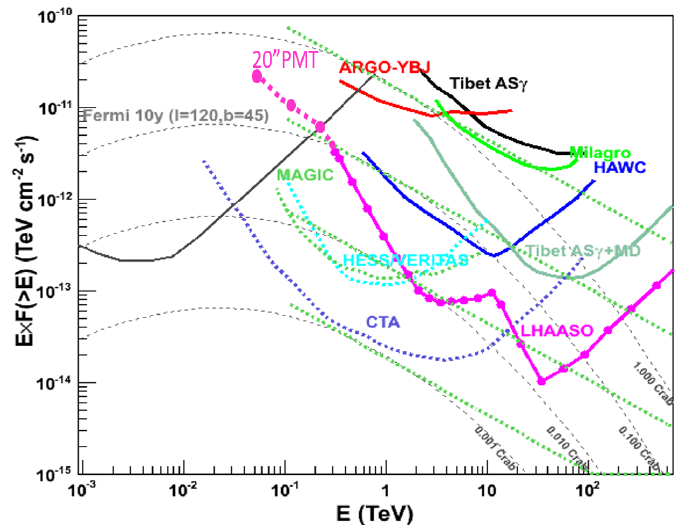
Figure 4. Sensitivities of VHE and UHG γ -ray astronomical instruments as functions of γ -ray energy, E. The Crab Nebula SED in a log-parabola functional form in gray short dashed lines has been adopted from Ref. [15], and the power law extension has been normalized at 1 TeV to be the same as the log-parabola. The ground based EAS experiments, AS γ + MD [19], HAWC [20], ARGO-YBJ [21] and MILAGRO [22] are represented by colored solid lines. The IACT experiments, CTA [23], VERITAS [24], HESS [25],MAGIC [26] are represented by colored dotted lines. The 10 year sensitivity of FERMI-LAT [27] is represented by the gray solid line. LHAASO sensitivity represented by the pink solid line is from Ref. [15] and the extension in low energies down to 50 GeV in dashed line is newly estimated based on the upgraded deployment using 20”